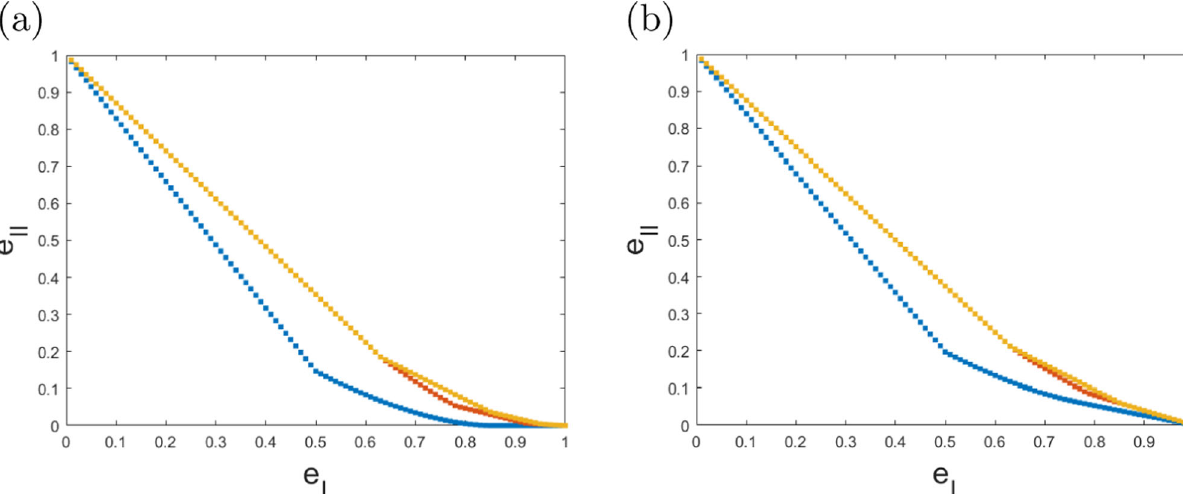
(cid:4) (cid:5) (cid:4) ¼ 1 ffiffi Fig. 3 One-shot entanglement certi fi cation for ϕ p ð 00 j i þ 1 þj iÞ . The referee has access to measurement strategies from the sets M 1 (blue), M 2 2 (red), M 3 (yellow). We display the mimimal e II for fi xed e I . As each game corresponds to a hypothesis test, the most reasonable fi gure of merit is to quantify the type-I and type-II errors (e I , e II ) a referee could achieve. These error pairs lie above the respective curves in the plots, any error-pair below is not possible with the resources at hand. Our optimisation also provides us with an explicit POVM, i.e., a measurement protocol, that achieves the optimal (cid:4) (cid:5) (cid:4) are e I + e II = 0.6464 with M 1 , e I + e II = 0.8152 with M 2 , error pairs. a Entanglement detection for exact state preparation. The minimal total errors for ϕ and e I + e II = 0.8153 with M 3 . For most randomly sampled states, these errors are much larger. We remark that there are also states, such as the singlet, (cid:4) (cid:5) (cid:11) (cid:4) (cid:4) (cid:4) ϕ where M 2 and M 3 lead to identical optimal errors. b Entanglement detection for noisy state preparation. To enforce that all states close to ρ ¼ ϕ remain undetected with probability at most e II , we need to invoke eq. (7), with C ¼ f ρ 0 : ρ 0 (cid:11) 0 ; tr ð ρ 0 Þ ¼ 1 ; k ρ (cid:7) ρ 0 k 1 (cid:10) ϵ g . In the Methods we show how to derive the dual to this set. The plot displays the ϵ = 0.1